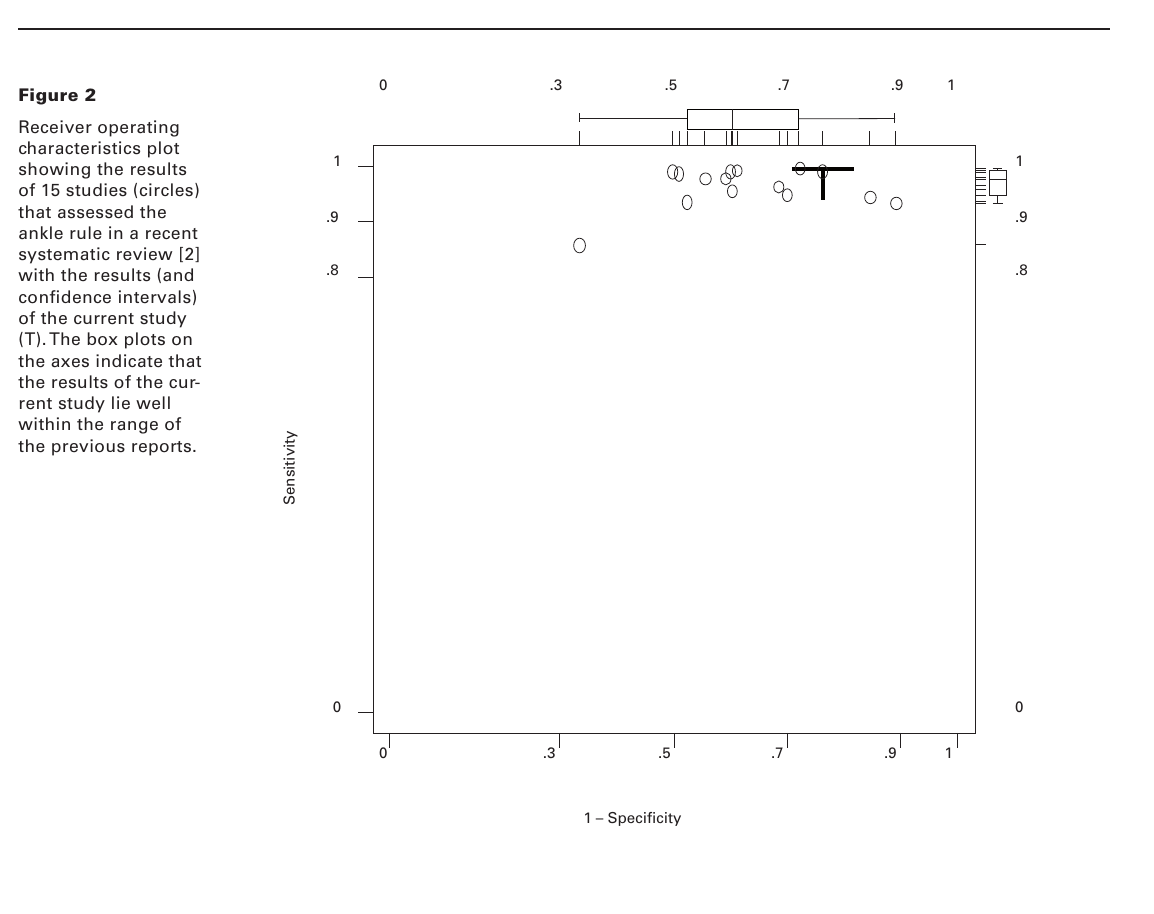
Shows results of the 2x2 tables along with sensitivity and specificity for the complete cohort and the two subgroups of surgeons and non- surgeons.